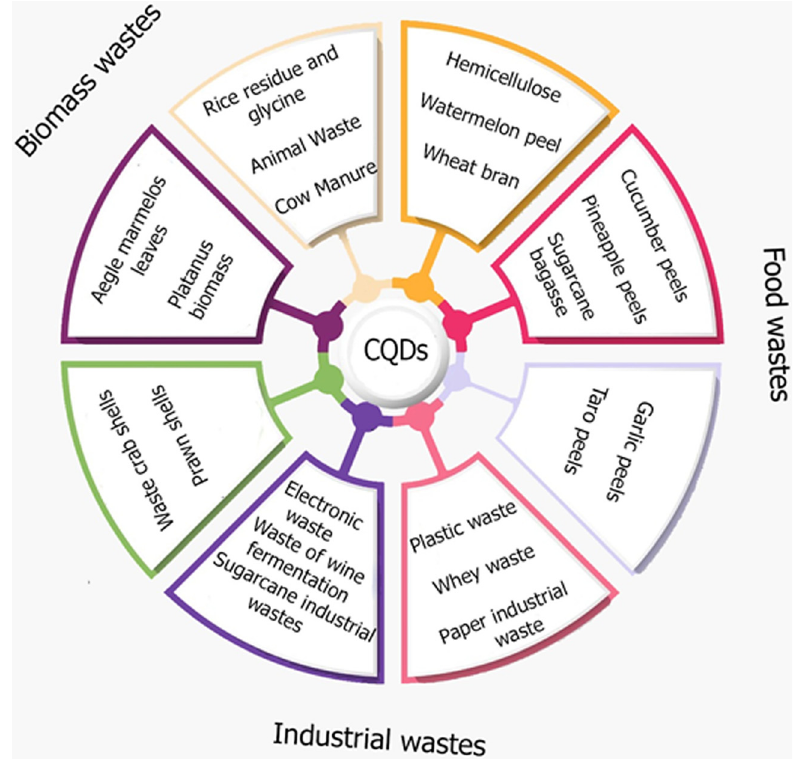
Figure 12: Wastes used as precursors for synthesizing